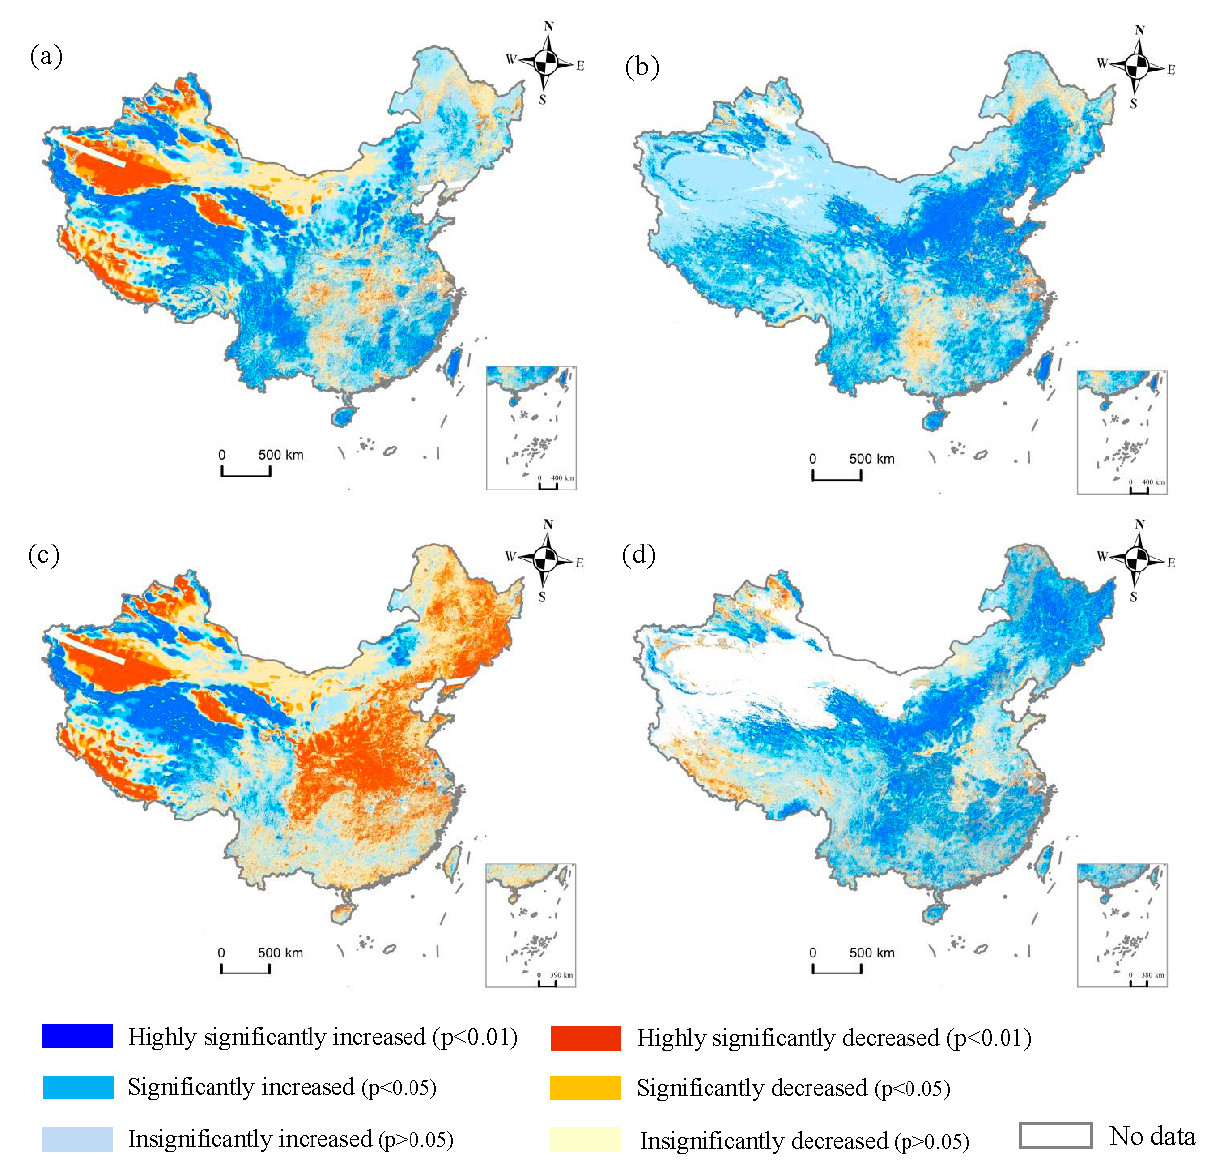
Figure 3. The interannual variation of ET components across China during 2001–2020. ( a ),( b ),( c ) and ( d ) are ET, Ec, Es and Ei, respectively.